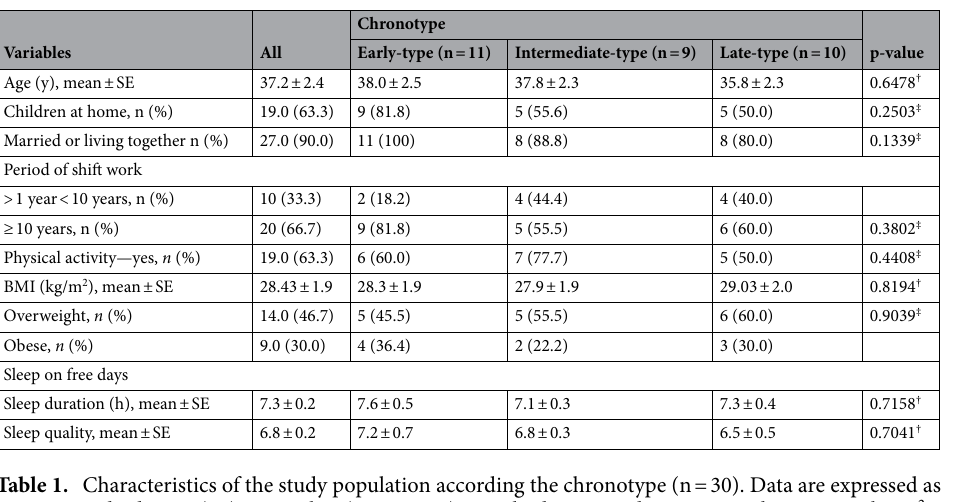
Table 1. Characteristics of the study population according the chronotype (n = 30). Data are expressed as mean ± standard error (SE) or number (percentage). BMI body mass index. Overweight BMI ≥ 25 kg/m 2 and < 30 kg/m 2 ; Obesity BMI ≥ 30 kg/m 2 , according to World Health Organization (2000) 29 . † ANOVA One way. ‡ Likelihood ratio test. Sleep duration data obtained by actigraphy. Sleep quality data obtained by the sleep